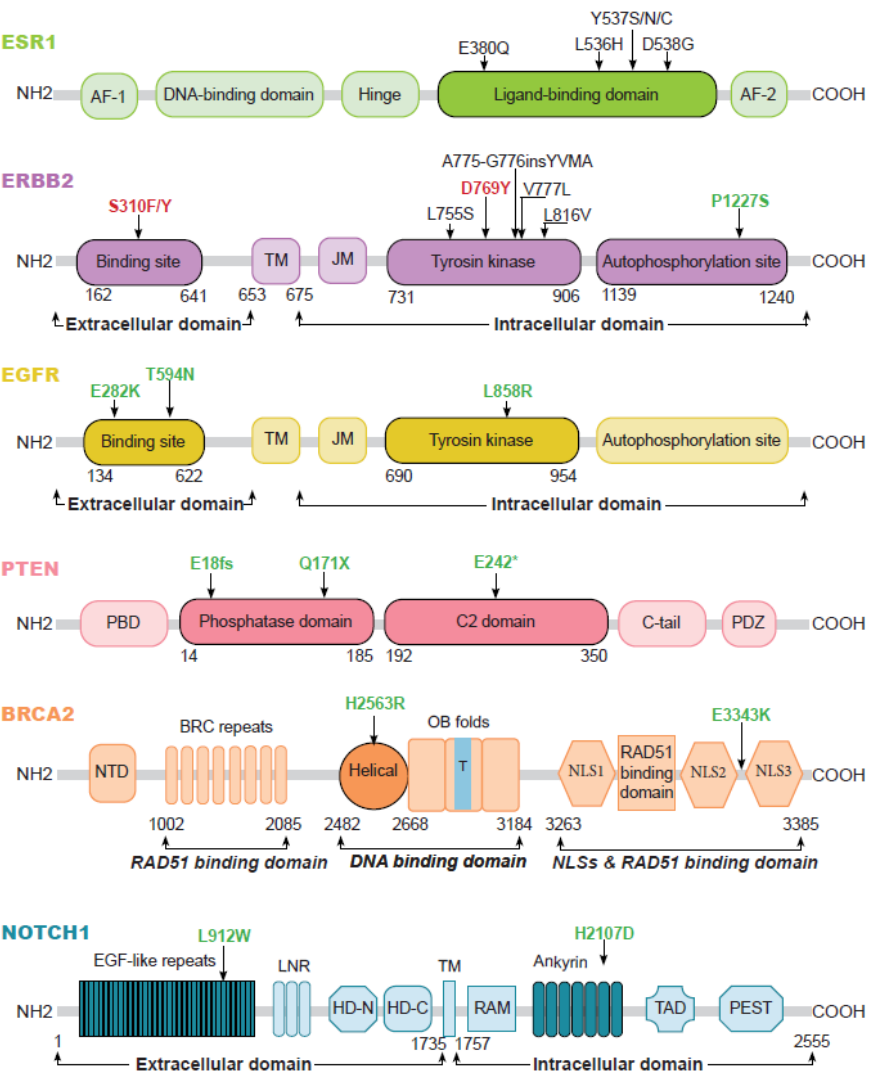
Figure 3. Cartography of the mutations reported in the meta-analysis for the 6 genes with an increased mutation prevalence in brain metastases. Mutations exclusive to brain metastases are identified in green. Those exclusive to extracerebral metastases are in red, and the mutations common to both sites are in black. AF-1: activation function-1, AF-2: activation function-2, TM: transmembrane,